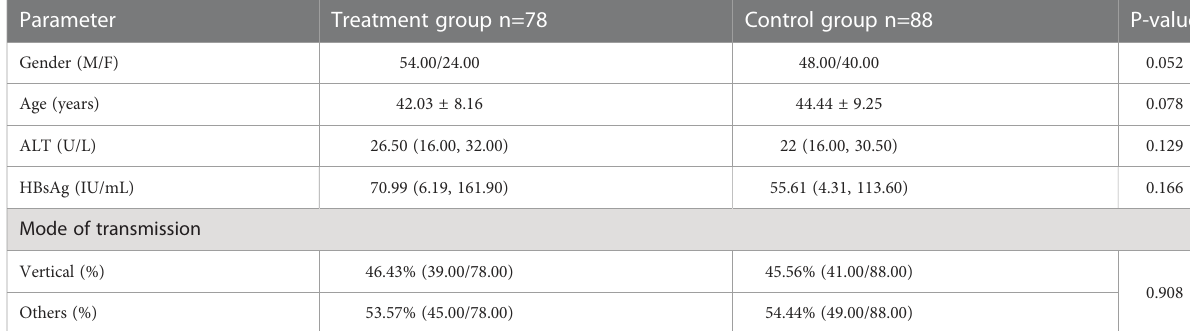
TABLE 1 Baseline characteristics.